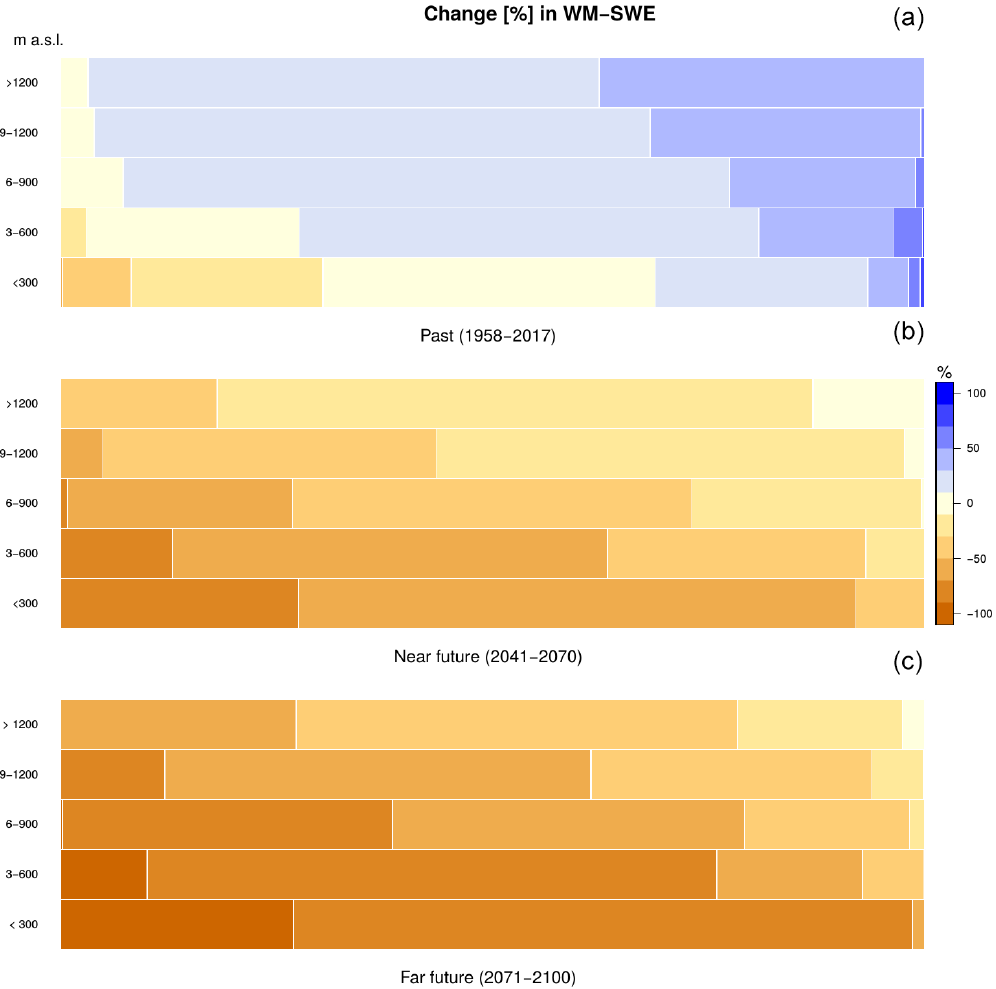
Figure 6. Percentage change in winter maximum SWE in different elevation levels for the historical period (change between 1958–1987 and 1988–2017; a ), the near future (change between 1981–2010 and 2041–2070; b ) and the far future (change between 1981–2010 and 2071–2100; c ). The length of the coloured bars represent the fraction of grid cells within the different intervals of change given by the